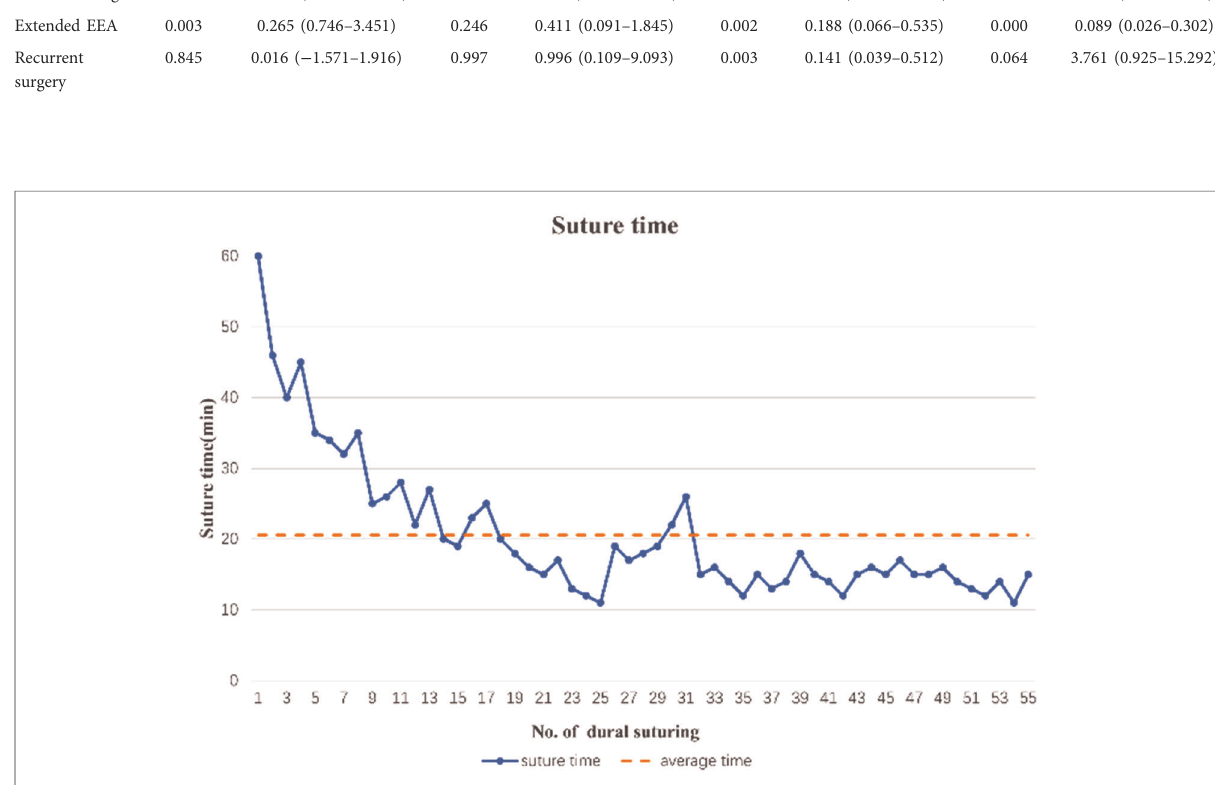
FIGURE 3 Time required for dural closure. The dotted line represents the average